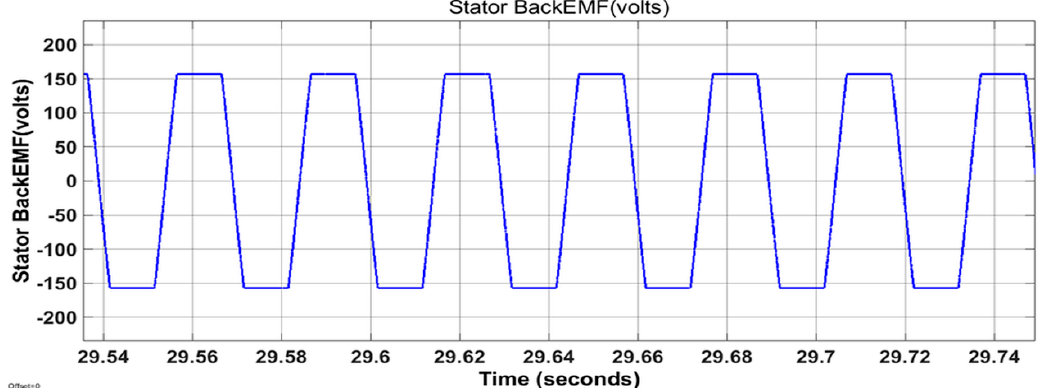
Figure 6. Back-Electro Motive Force waveform in phase A over 50 s.